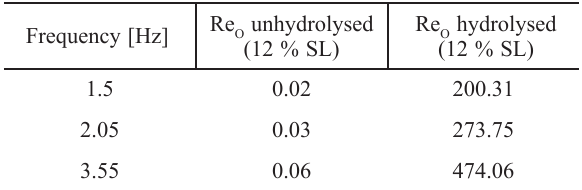
Table 2 – Oscillatory Reynolds numbers for hydrolysed and unhydrolysed samples Frequency